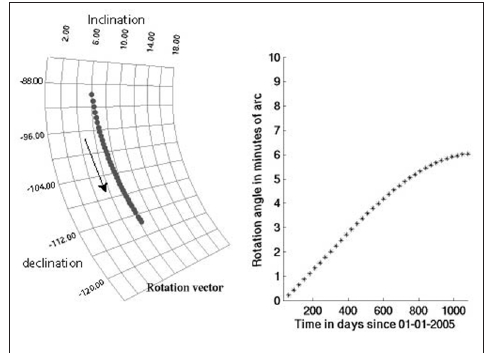
Fig. 7. Left: drift of the rotation vector accounting for the assumed rotation of the magnetometer sen- sors over the time span 2005-2007. Right: rotation angle versus time. See Section 3.2 for further expla- nations on the meaning of the